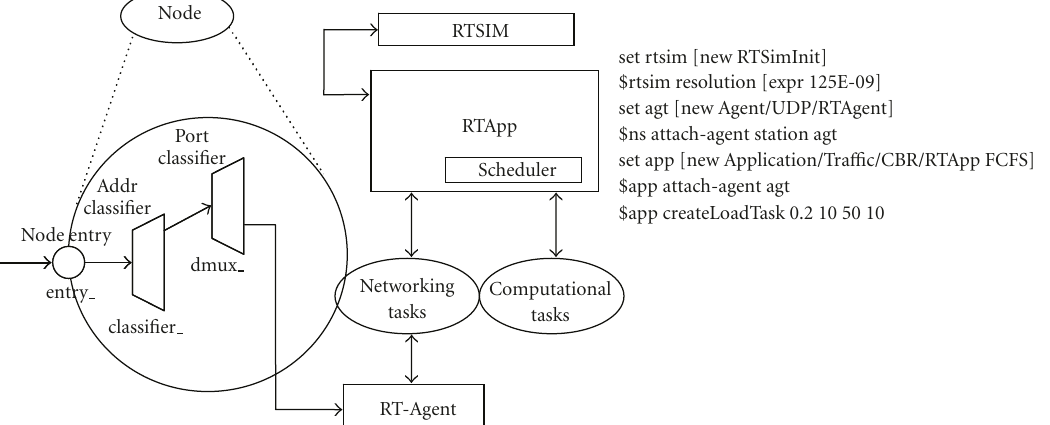
Figure 5: An example for setting up a 8MHz CPU running an OS with FCFS scheduling policy and a task set generating a computational load of 0.2. The parameters of the RTNS API (in TCL scripting language) follow the color scheme of the figure on the left: in Green the RTSim scheduler instance accustomed for the CPU speed, in Purple the NS-2 networking protocol, in Blue the OS abstraction with the scheduler in Red , in Orange the Task Set generating the load.